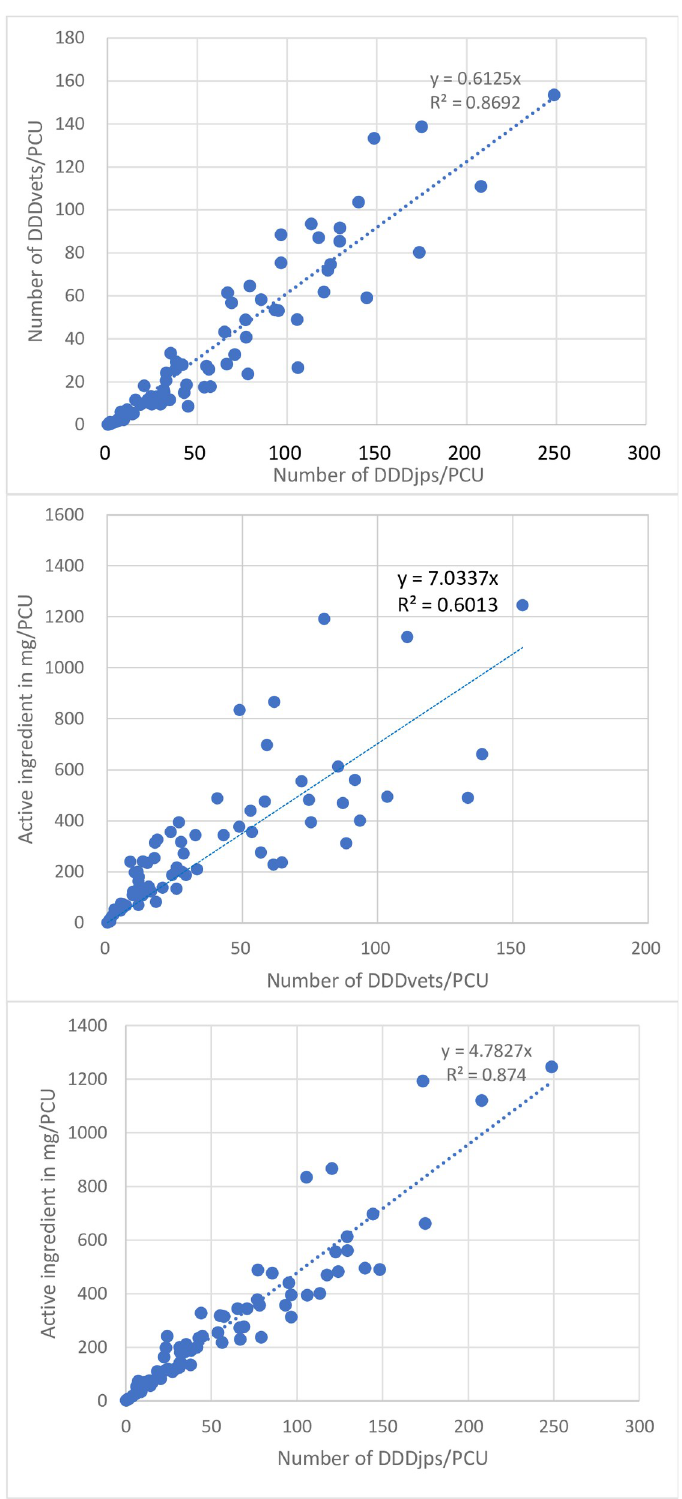
Fig 4. Scatterplots of weight of active ingredient and defined daily doses (DDD) per kg of PCU (population correction unit) at the farm level calculated using Japanese values (DDDjp) and European values (DDDvet). Each circle represents one farm (n = 74). After each dataset was tested for normality using the Shapiro-Wilk test with the